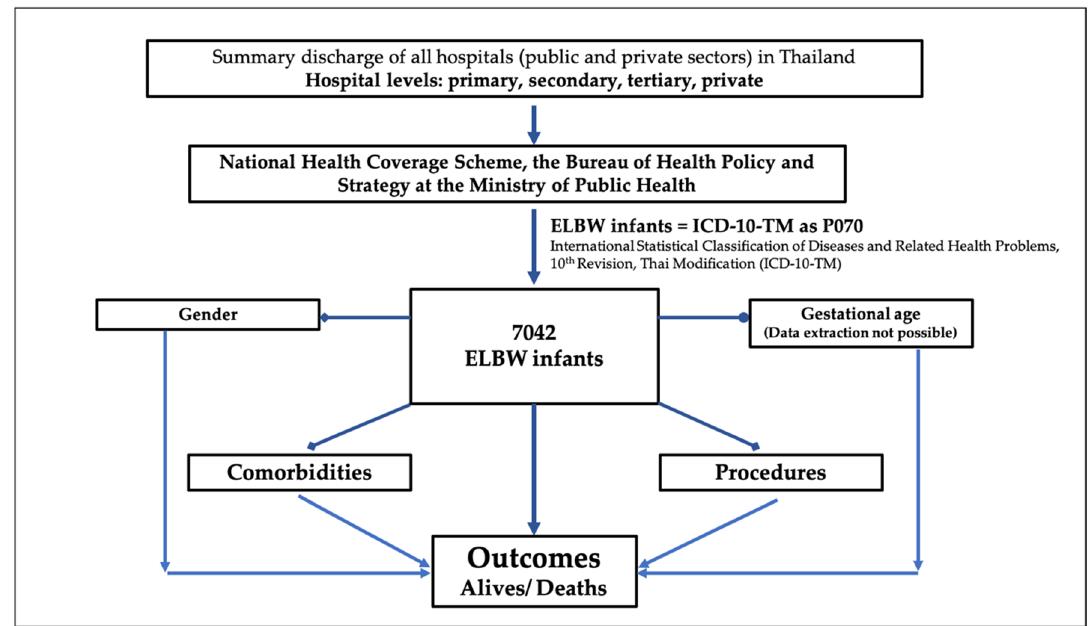
Figure 1. A summary flowchart of the study.